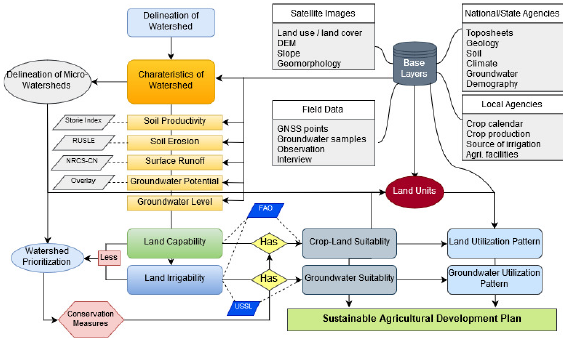
Figure 1 Workflow of developing an operational methodology for sustainable agricultural